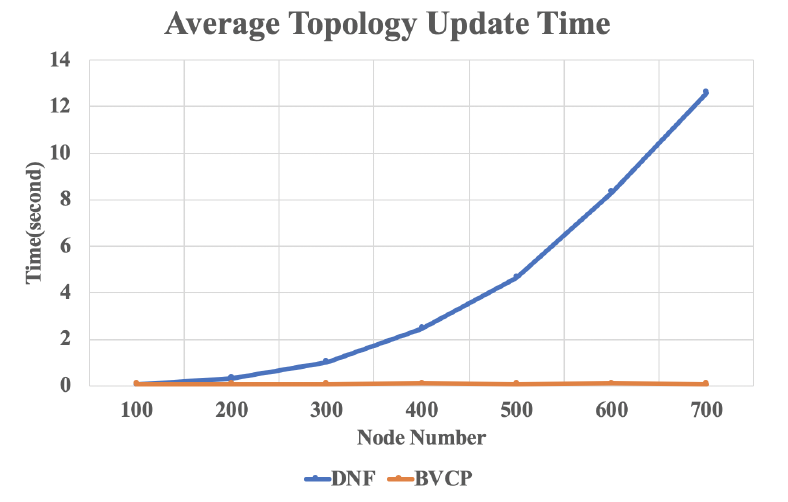
Figure 9. The result of average topology update time.